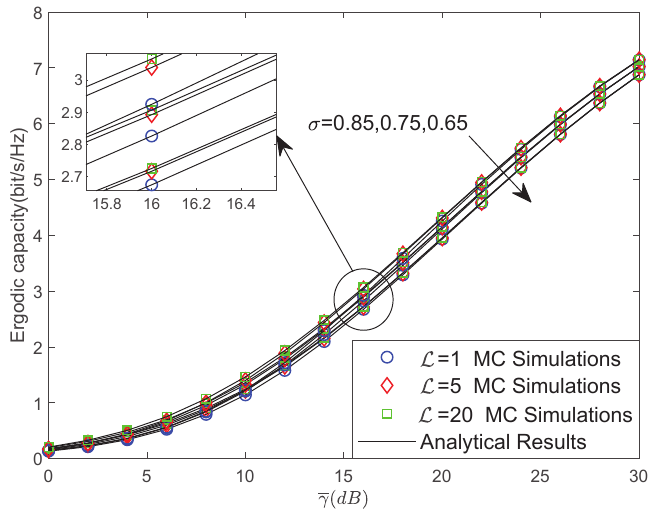
Figure 3. The EC versus ¯ γ for different CEEs situations.